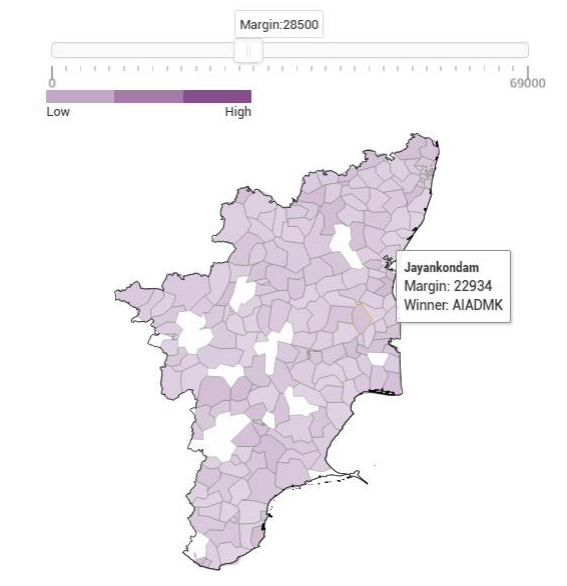
Figure 11: Winning Margins through a Slider Controlled Heat